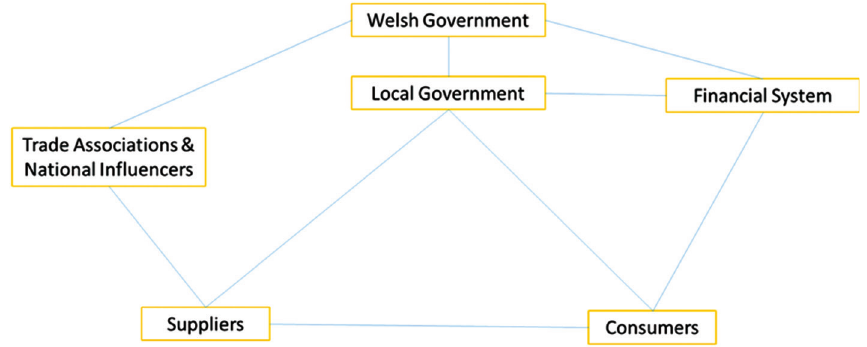
Figure A1 Prototype systems